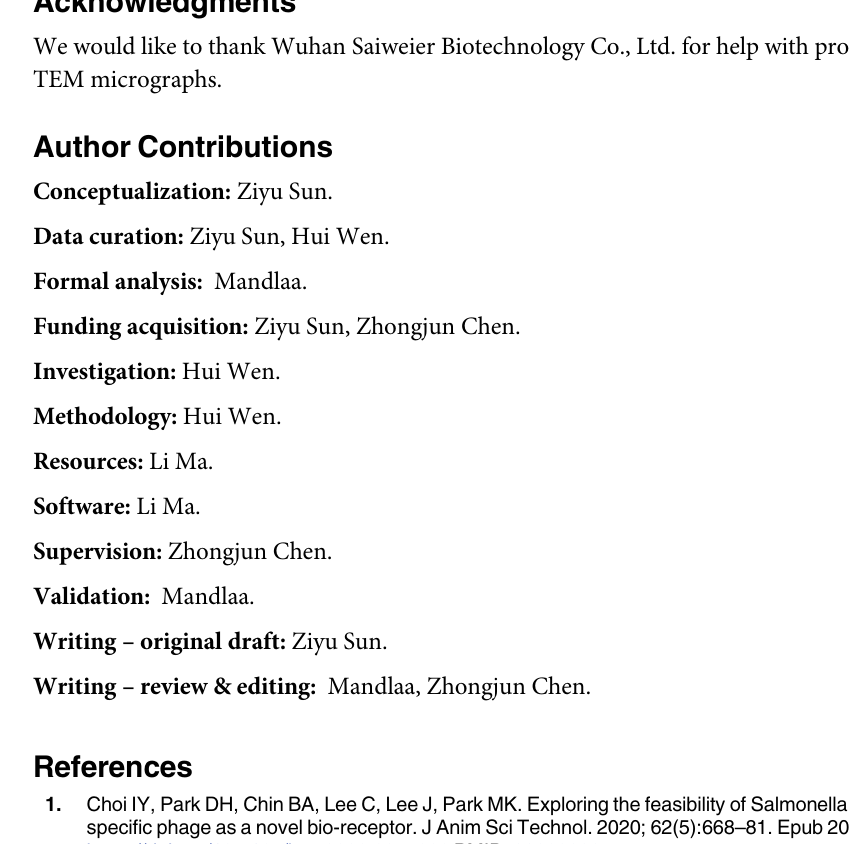
S1 Fig. Adsorption assay of PSDA-2 to host strain S .Typhimurium (CMCC50115). S1 Table. The number of homologous genes in the eight